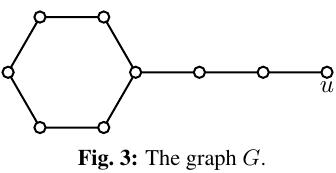
Fig. 3: The graph G